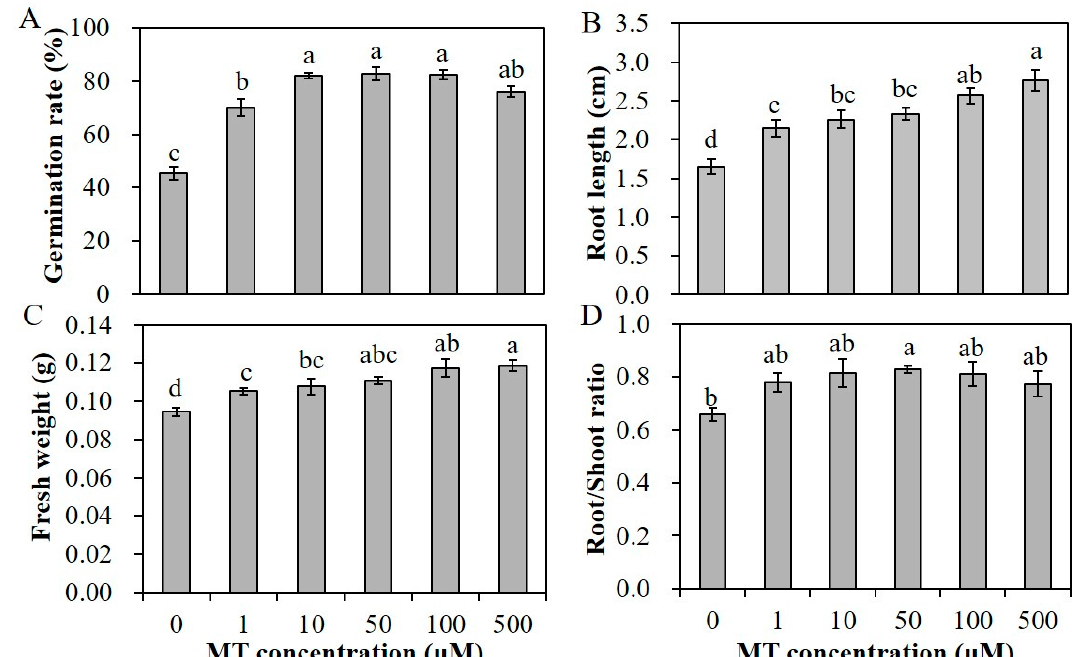
Figure 2. Germination rate ( A ), root length ( B ), fresh weight ( C ) and root/shoot ratio ( D ) of alfalfa seedlings pretreated with various concentrations of MT (0, 1, 10, 50, 100 and 500 µM) and germinated under 200 mM NaCl for 7 days. Data are represented as means ± SE ( n = 3), and bars with different letters indicate the differences between these different treatment groups according to ANOVA analysis ( p < 0.05).